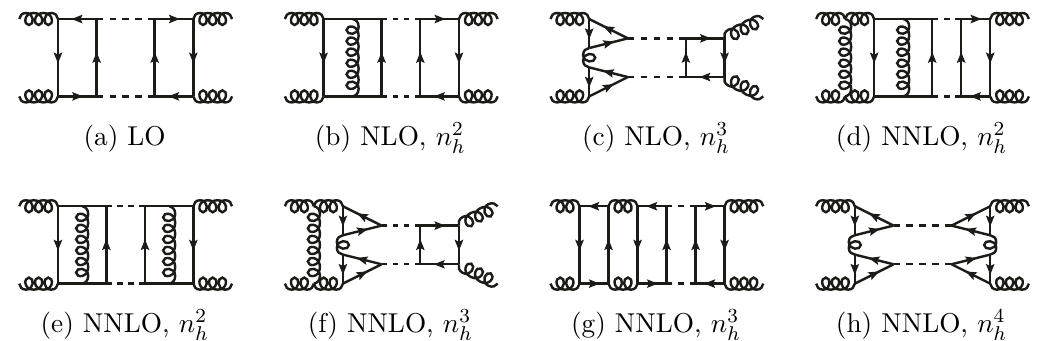
Figure 11 . Sample forward-scattering Feynman diagrams for the virtual corrections at LO, NLO and